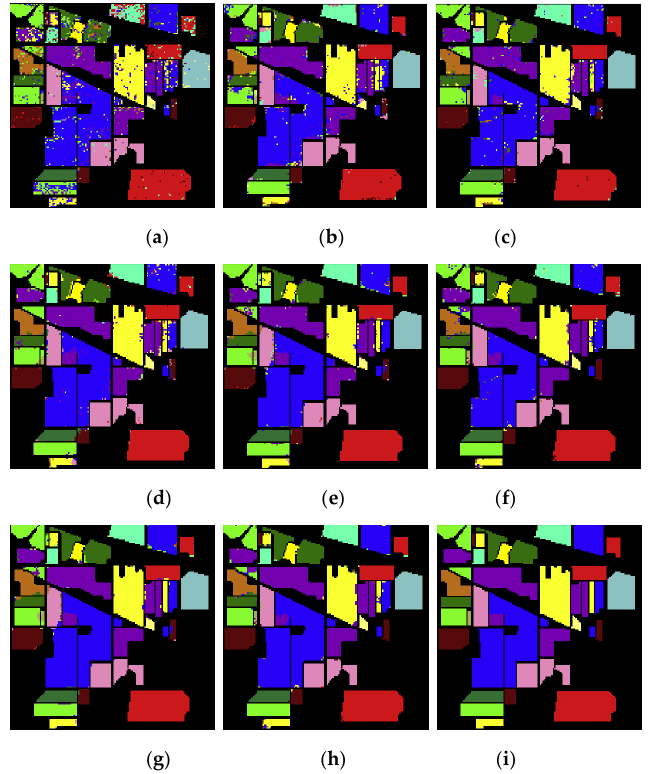
Figure 9. The classification results on Indian Pines dataset: ( a ) SPE; ( b ) PCA1; ( c ) PCA1_SPE; ( d )